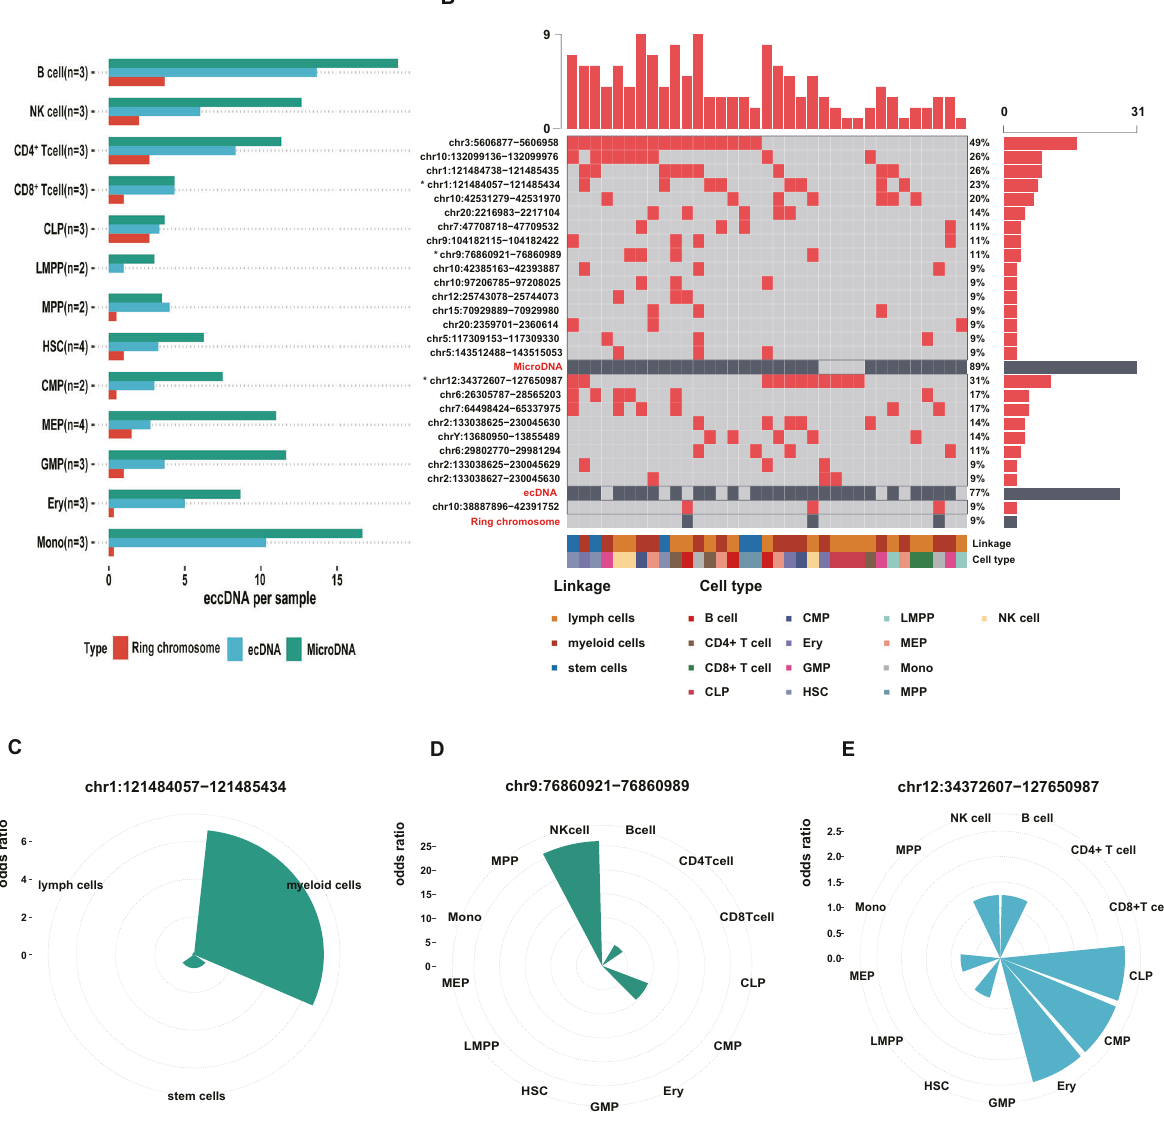
Fig. 1 The recurrent eccDNAs across all cell types of normal hematopoiesis. A The barplot shows the average number of eccDNA in 13 cell types of hematopoiesis. The X-axis represents the cell type; Y-axis represents the average number of eccDNA (the eccDNA types are shown in different colors). B Oncoplot displays the eccDNA landscape of normal hematopoiesis. EccDNA on the left denotes “ chromosome: chromosome start point − chromosome end point of breakage ” , e.g., “ chr3:5606877 − 5606958 ” . The eccDNAs are recurrent in different cell types and three type eccDNAs (microDNA/ecDNA/ring chromosome) were analyzed and ordered, respectively. The right bar represents the proportion of cells containing some kind of eccDNA in all normal cells. The samples at the bottom indicate according to the annotation bar (linkage and cell types). For example, the fi rst line of the oncoplot shows the proportion of cells containing chr3:5606877 − 5606958 is 49%. C The barplot demonstrates microDNA (chr1:121484057 − 121485434) is enriched in myeloid cells ( P = 0.039, Fisher ’ s exact test). D The microDNA (chr9:76860921 − 76860989) is enriched in NK cells ( P = 0.025, Fisher ’ s exact test). E The ecDNA (chr12:34372607 − 127650987) is enriched in CLP ( P = 0.020, Fisher ’ s exact test) and Ery cells ( P = 0.020, Fisher ’ s exact test). In fi gure1C-E, the x-axis represents the different cells, the y-axis represents the odds ratio occurrence proportion (Fig. 1B). Subsequently, we analyzed all cell differentiation (Fig. 1A). The landscape of eccDNAs in eccDNAs in Fig. 1B to explore which cell types were mainly normal hematopoiesis directly represented the recurrent enriched in. The microDNA chr1:121484057 − 121485434 (or eccDNAs. Three type eccDNAs (microDNAs/ecDNAs/ring chro- tandem gene duplication) was enriched in myeloid cells mosomes) were analyzed and ordered respectively. The ( P = 0.039, Fig. 1C, Fisher ’ s exact test). The microDNA Oncoplot showed the percentage of cells containing microDNA chr9:76860921 − 76860989 mainly occurred in the NK cells chr3:5606877 − 5606958 (or tandem gene duplication) in all cells ( P = 0.025, Fig. 1D, Fisher ’ s exact test). And the ecDNA was 49%, which indicated the microDNA chr3:5606877 − 5606958 was the most recurrent microDNA in normal chr12:34372607 − 127650987 tended to happen in CLP and Ery cells (both P < 0.05, Fig. 1E, Fisher ’ s exact test). hematopoiesis. All eccDNAs were ordered according to